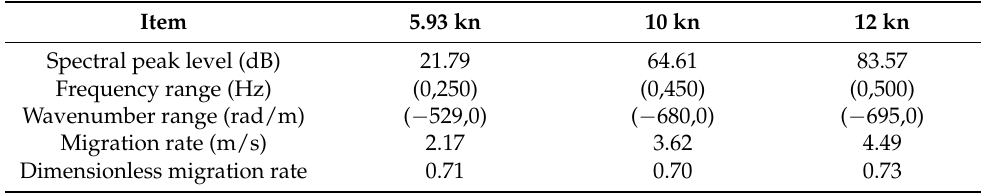
Table 6. The parameters of the wave-number frequency spectrum.